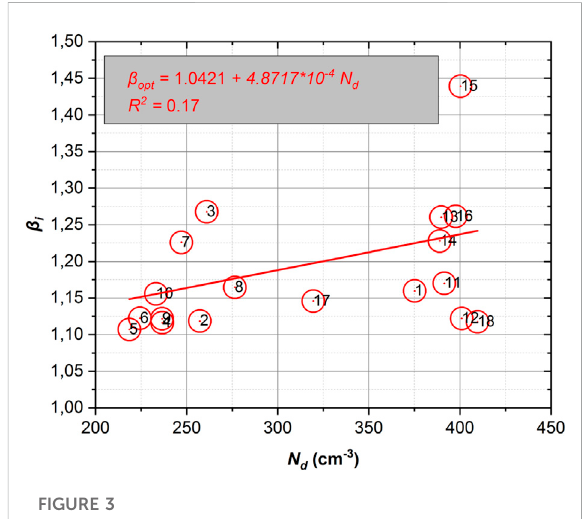
FIGURE 3 The linear interpolations over the β - N d data for the diabatic derived N d ; the labeling refers to the serial number of each cloud ( c.f . Supplementary Figure